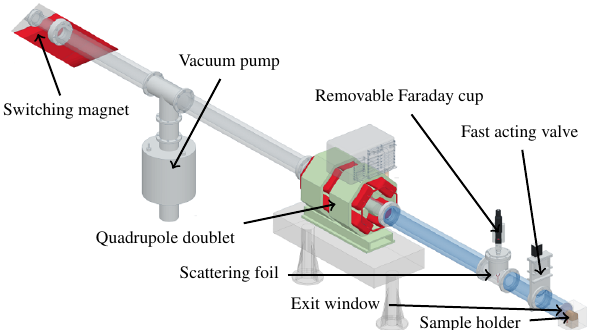
Figure 4. Schematic diagram of the proposed beamline design to produce an external beam at HIAF.